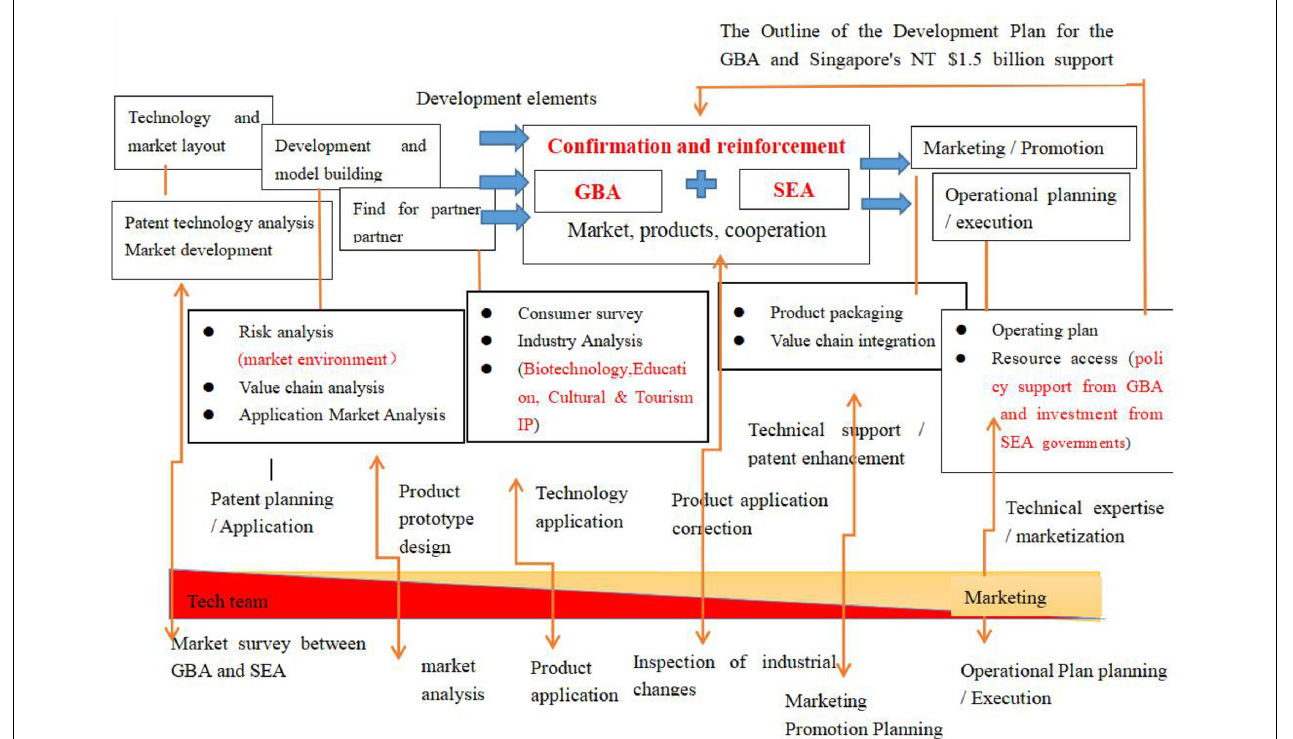
FIGURE 2 | Dynamic teamwork path evolution from idea to market of